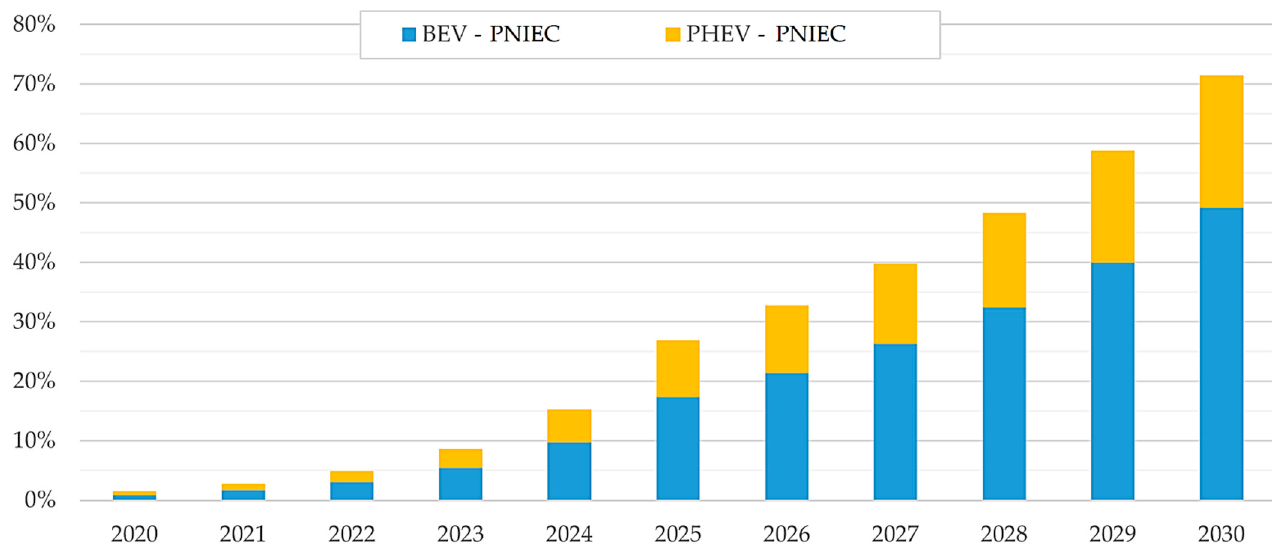
Figure 7. Estimated average BEV and PHEV penetration index on car sales from 2020 to 2030 at Italian level (PNIEC scenario).